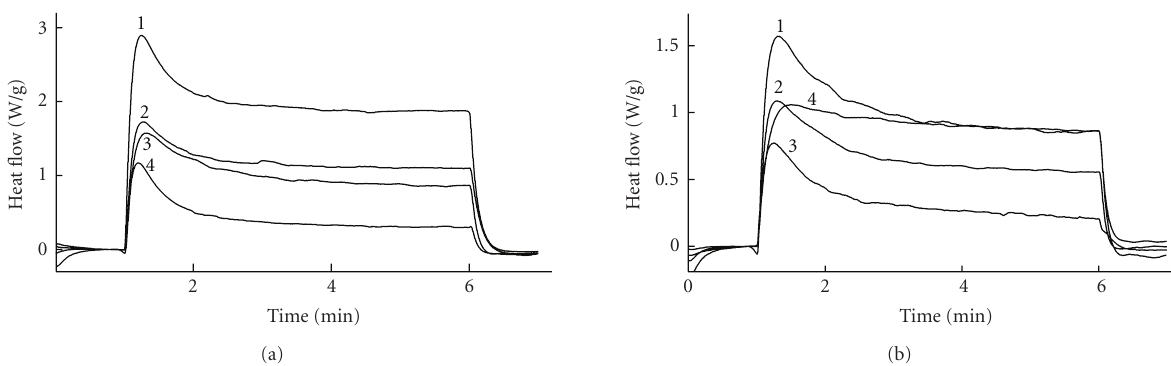
Figure 1: DSPC thermograms for photopolymerization. (a) 1: MMA, 2–4: MMA containing 5wt.% of Diimide, PI 2 and PI 1; (b) MMA containing 5 (1), 10 (2), 20 (3), and 42wt.% of PI 2 (4).